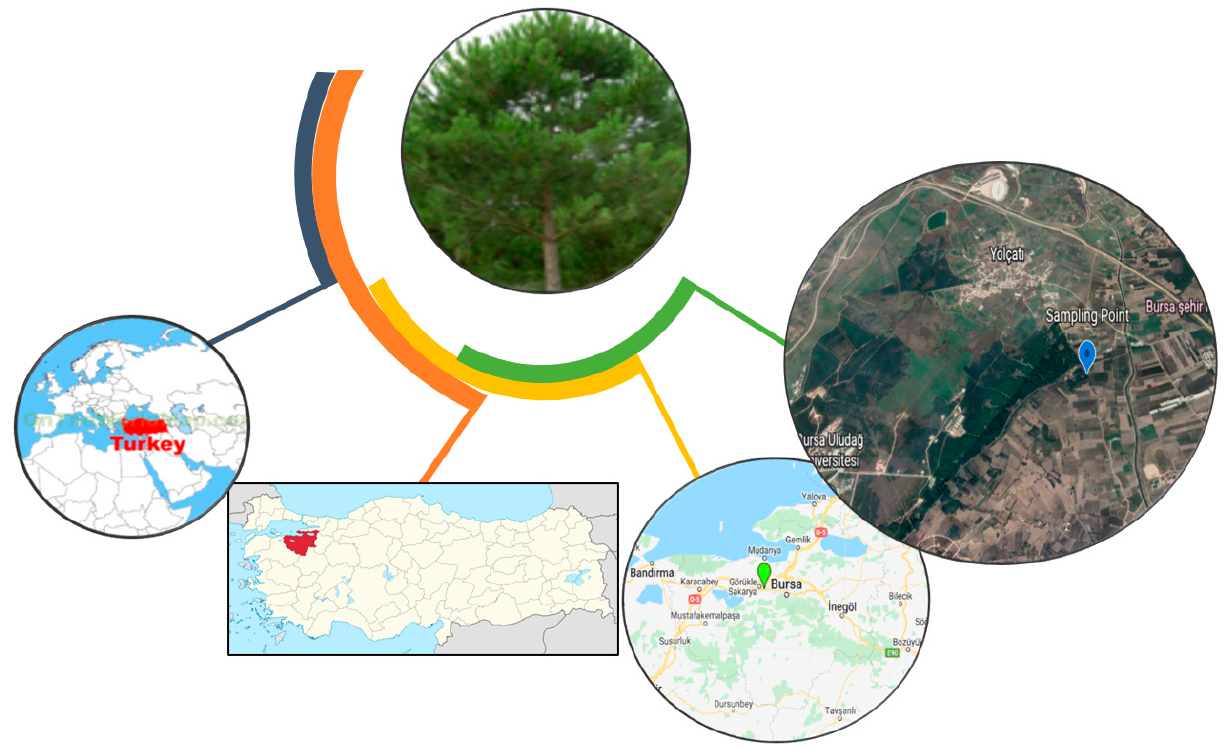
Figure 1. The location of the sampled pine